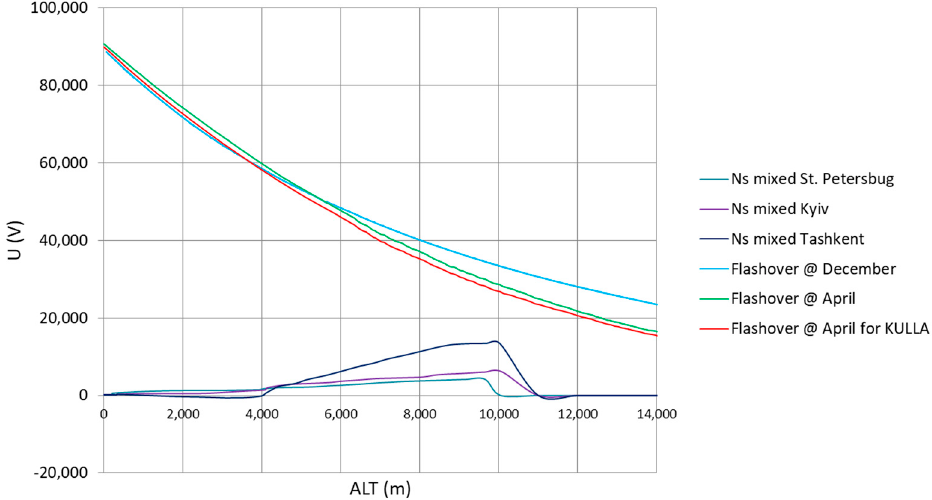
Figure 3. The flashover and induced voltage through the Nimbostratus clouds on the 140 m-long fully airborne antenna during the